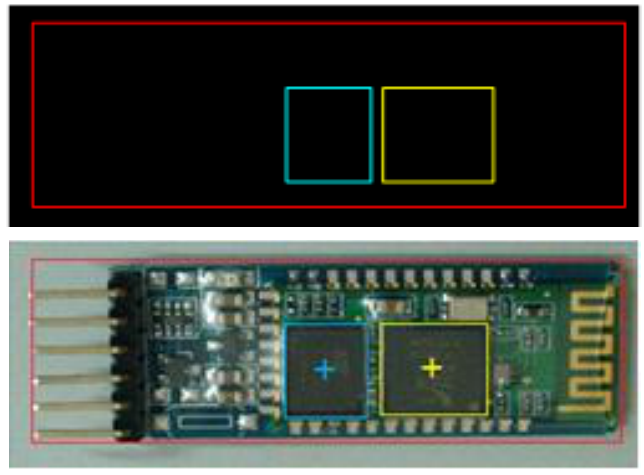
Figure 16. Case of Bluetooth module identification.